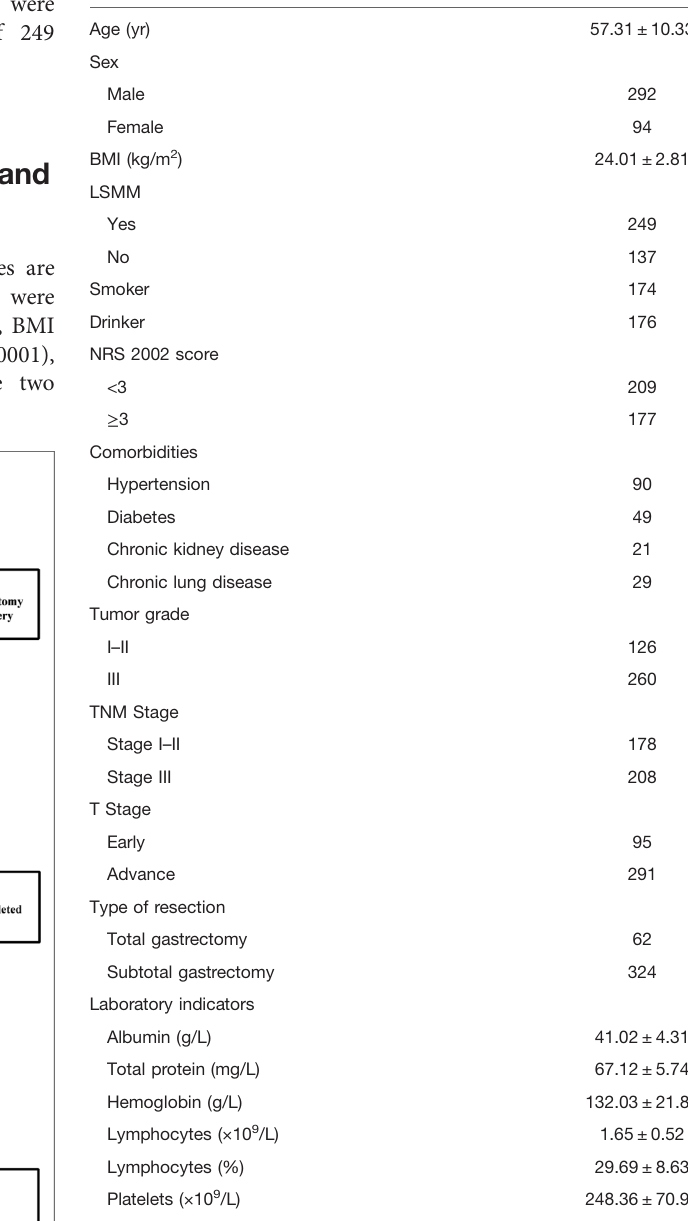
TABLE 1 | Characteristics of the study